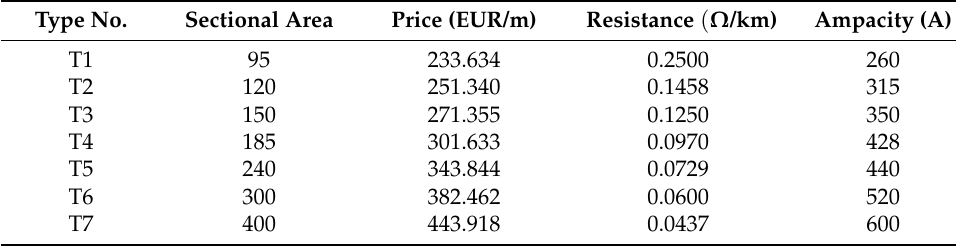
Table A2. Basic technical and economic data for 66 KV, XRUHAKXS